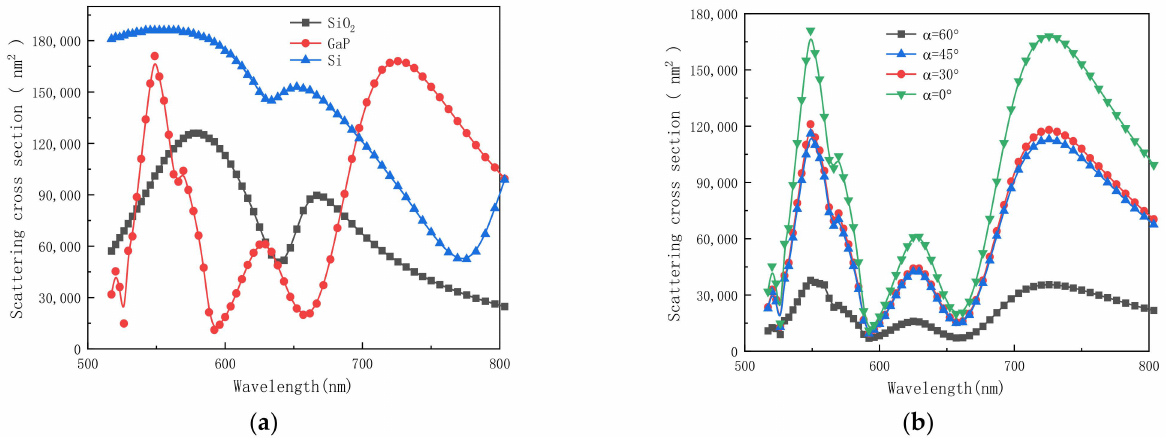
Figure 5. ( a ) Scattering cross-sections of three different dielectric materials for the nanoring and ( b ) comparison of the scattering cross-sections in different directions of the incident